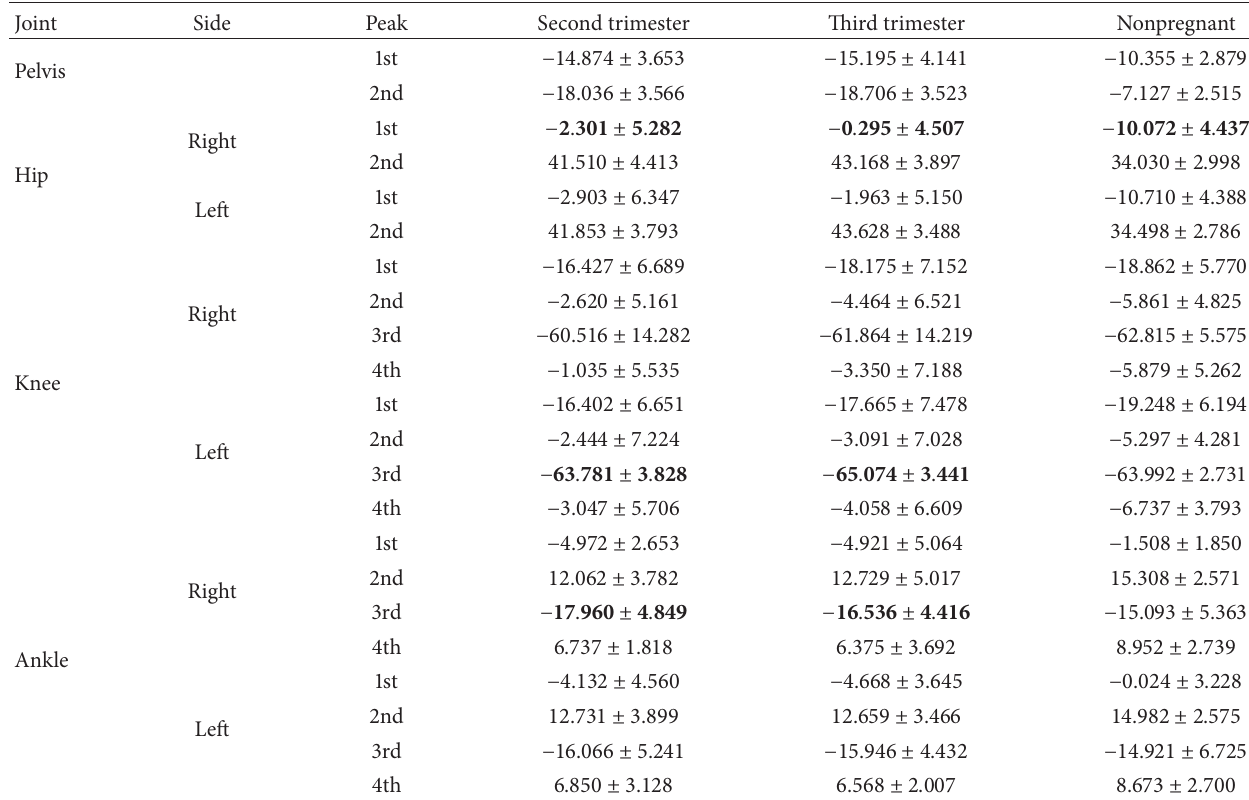
Table 2: Joint kinematic peak values (mean) of gait in the sagittal plane, during the second and third trimesters of pregnancy ( 𝑁 = 22 ) and nulliparous controls ( 𝑁 = 12 ). Units (mean ± sd) are in